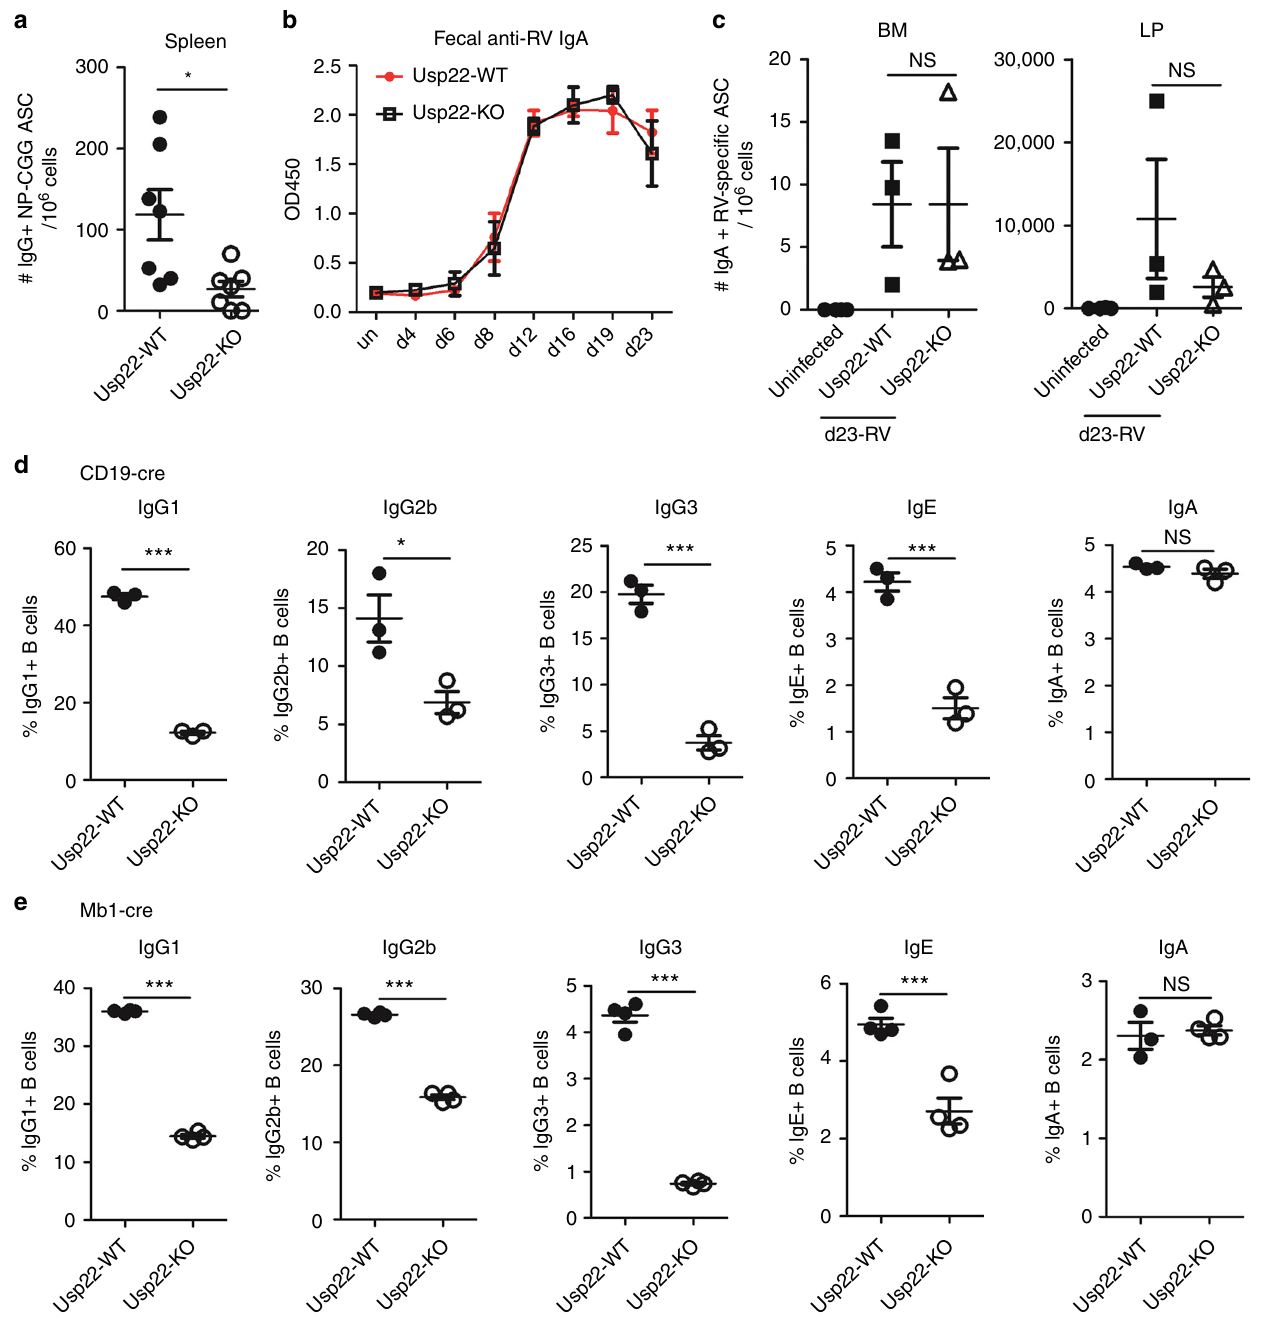
Fig. 2 Usp22 KO mice exhibited defective IgG/IgE CSR but not IgA CSR. a NP 25 -CGG plus alum was intraperitoneally injected into CD19-cre Usp22 KO